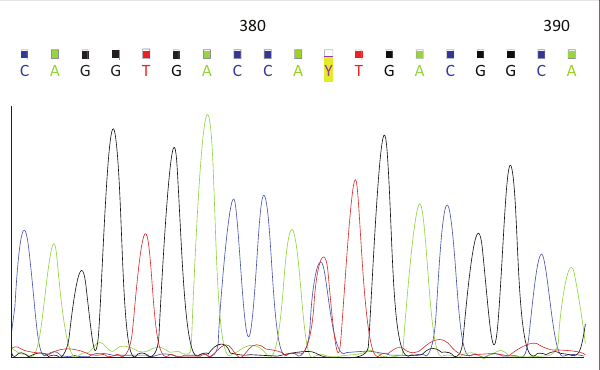
FIGURE 1: Electropherogram demonstrating heterozygosity for the c.341T>C (p.I114T) single nucleotide variation, Western Cape, South Africa, 2013–2016. Single nucleotide variants depicted by the red ‘Y’ highlighted in yellow.